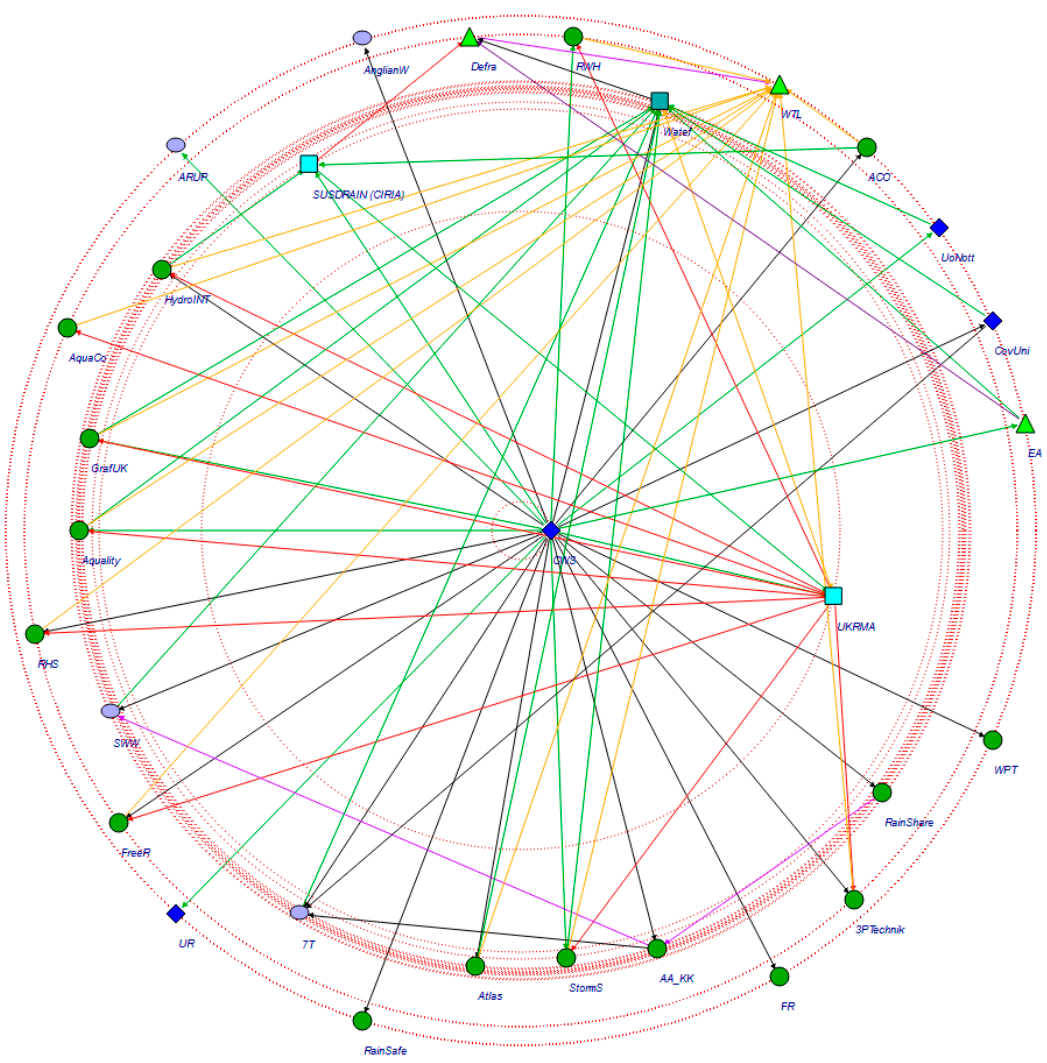
Figure 3. Influence range closeness centrality (IRCC) hierarchy for the rainwater harvesting network interaction model. Relationships: Green = knowledge exchange; Black = research; Purple = action; Red = Advocacy/lobbying; Orange = listed by WTL.